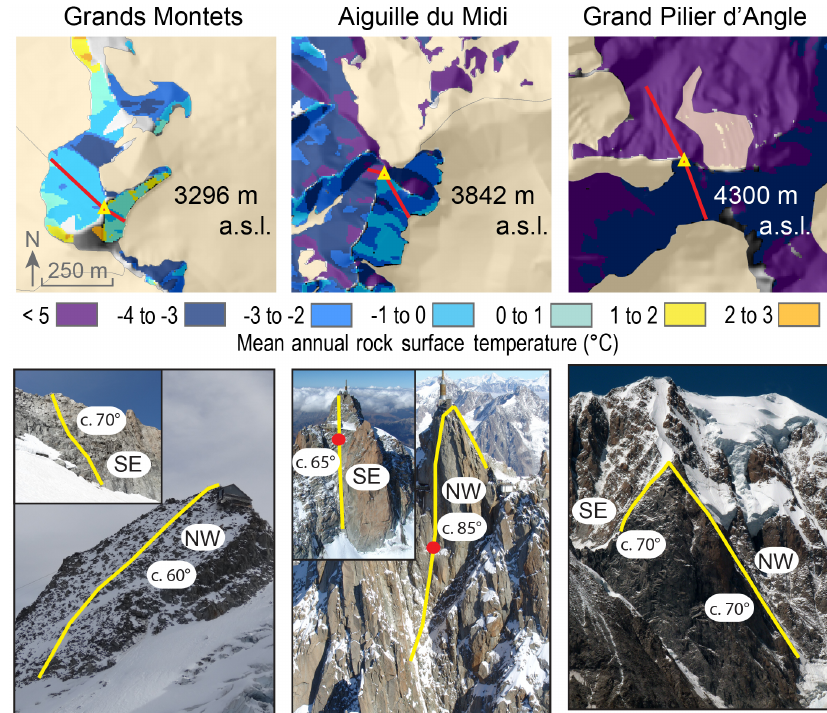
Figure 2. Topographical profile locations on the three